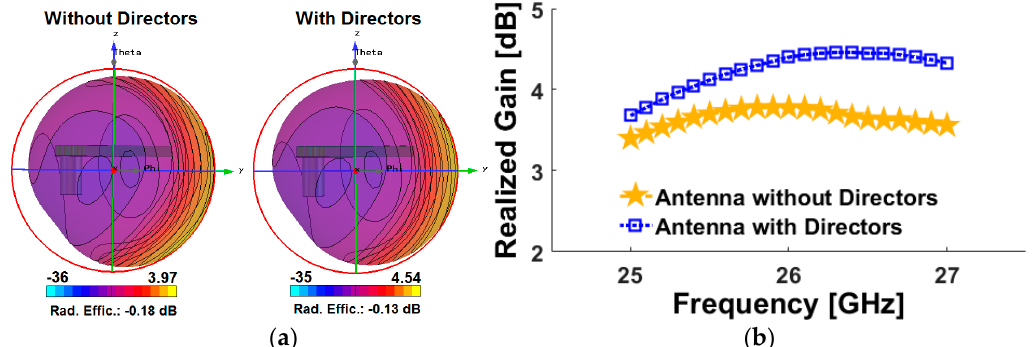
Figure 6. Comparison of the antenna performance with/without directors: ( a ) radiation pattern and ( b ) gain.